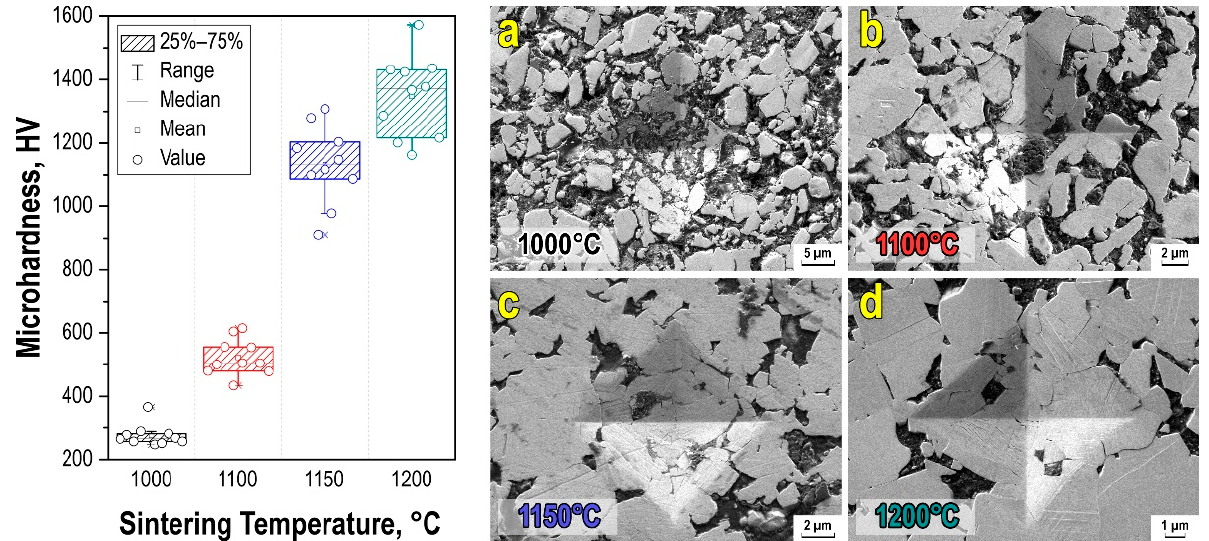
Figure 6. Vickers microhardness dispersion ( left ) of WC-10wt%Co ceramic samples, and micropho- tographs of microhardness indentor prints at HV0.5 on the surface of tested samples ( right ) WC- 10wt%Co obtained by SPS consolidation at different temperatures: ( a )—1000 °C (×5000); ( b )—1100 °C (×10,000); ( c )—1150 °C (×12,000); ( d )—1200 °C (×15,000).